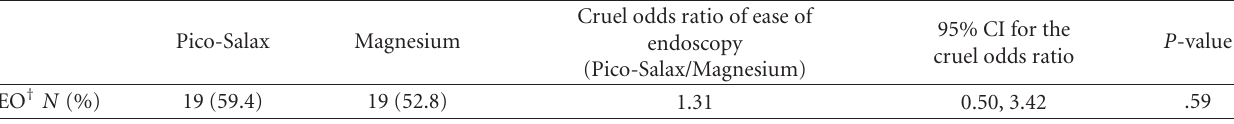
Table 2: Comparison of ease of colonoscopy between Pico-Salax and magnesium citrate.